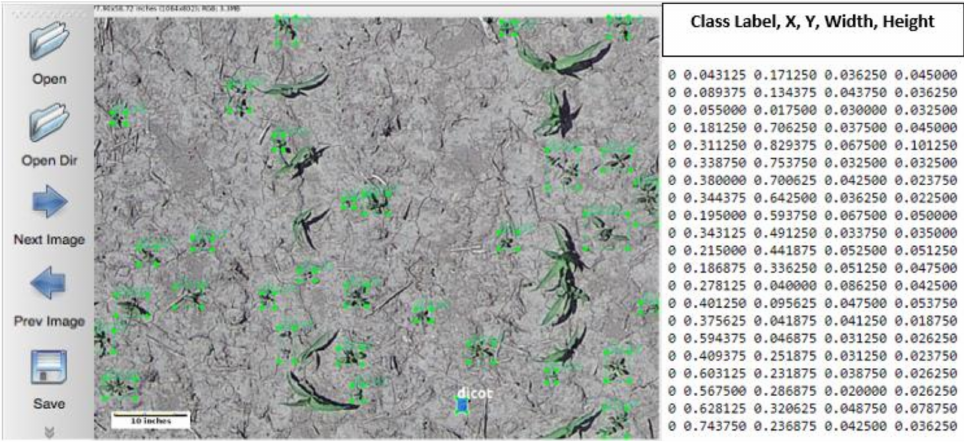
Figure 4. LabelImg manual labeling process and